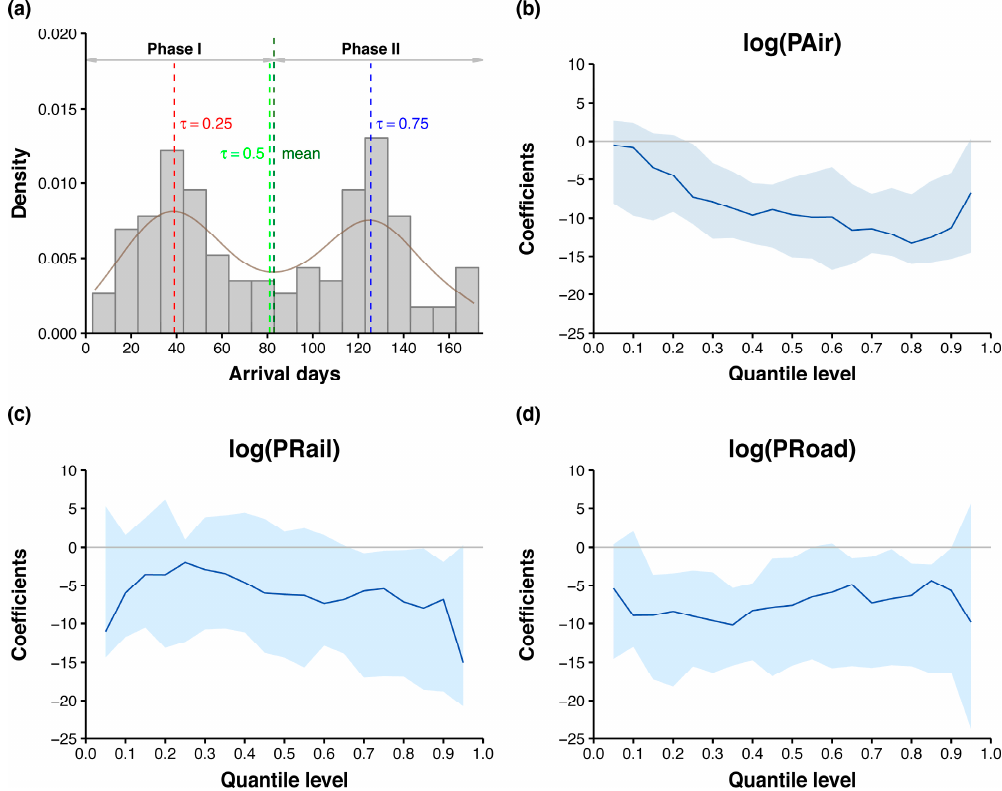
Figure 5. Quantile process regression of arrival days in 115 prefectures. In ( a ) the density plot of arrival days, the red, green, and blue vertical lines indicate, respectively, the 𝜏 = 0.25, 0.50, and 0.75 quantiles of arrival days, whereas the dark green vertical line indicates the mean arrival days. In quantile process plots for log-transformed air ( b ), rail ( c ), and road ( d ) passenger volumes, the blue curves and shaded areas represent the quantile regression coefficients and 95% confidence intervals.